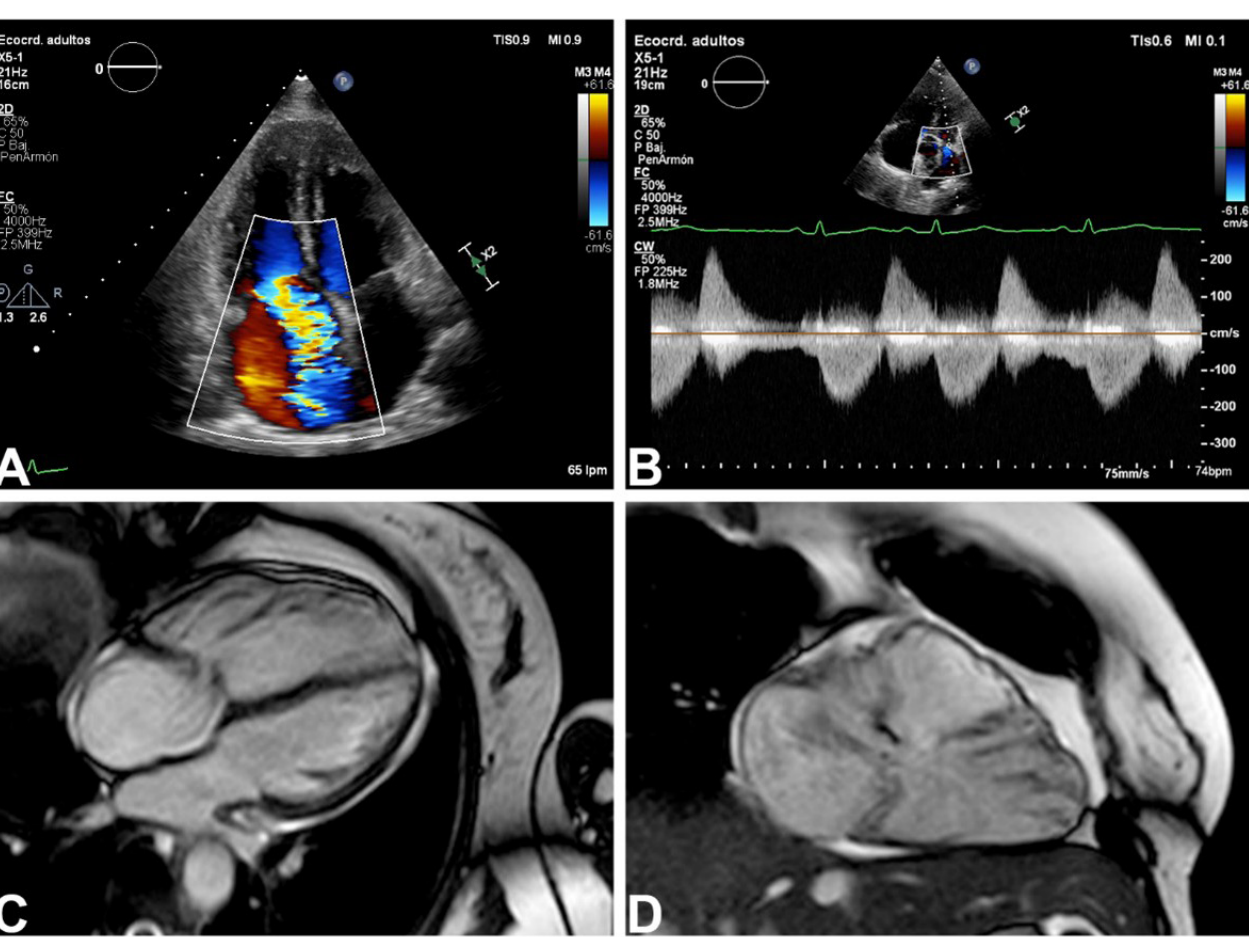
Fig. 1 - Echocardiography and cardiac magnetic resonance image (MRI) findings. On transthoracic echocardiography, the patient had severe tricuspid leaflet thickening causing severe regurgitation (A) and severe pulmonic regurgitation (B). On cardiac MRI, there is severe right ventricle dilation (C) and clear absence of valvar coaptation (C,